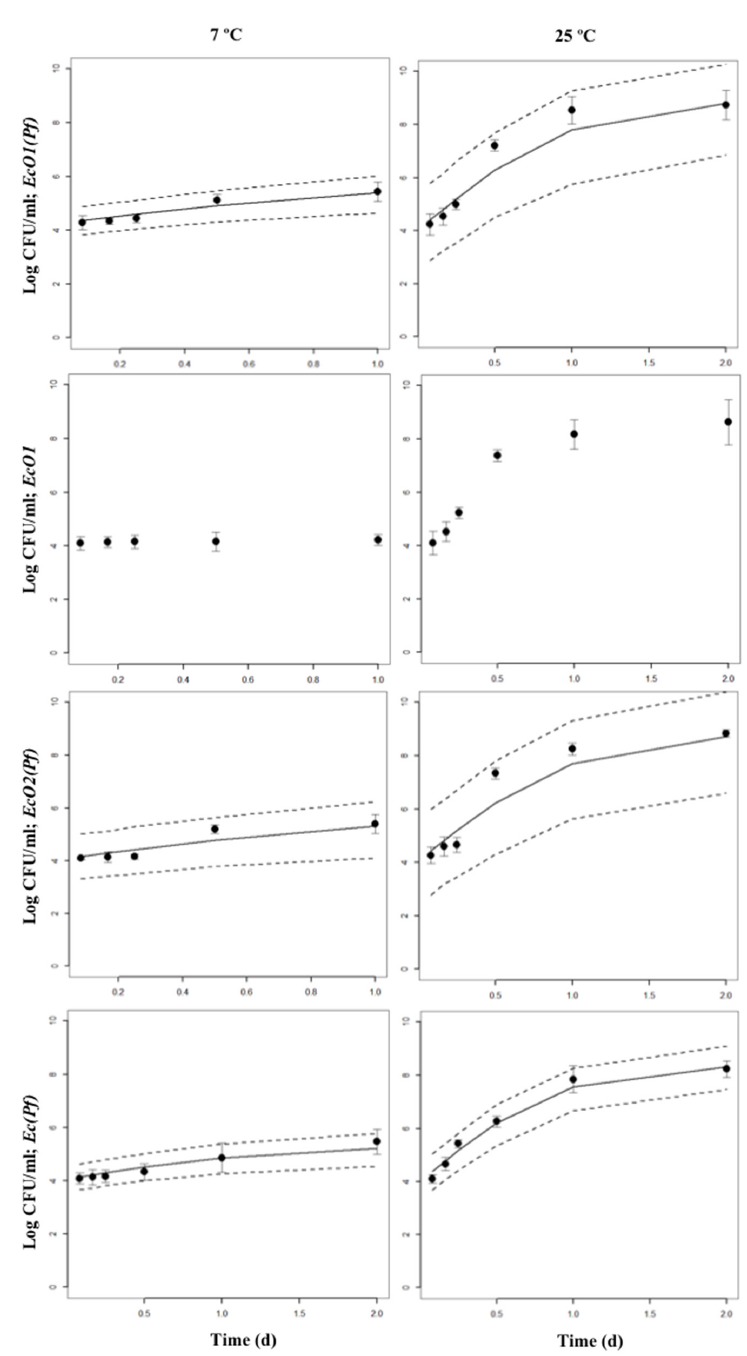
Figure 2. Bayesian inference of growth periods of co-cultures of E. coli spp. with P. fluorescens at 7 or 25 °C in skimmed milk. The 95% Highest Posterior Density intervals (2.5 and 97.5%) are shown. Points are the original data: mean and standard deviation are shown. Growth periods from EcO1 cultured alone are also shown.